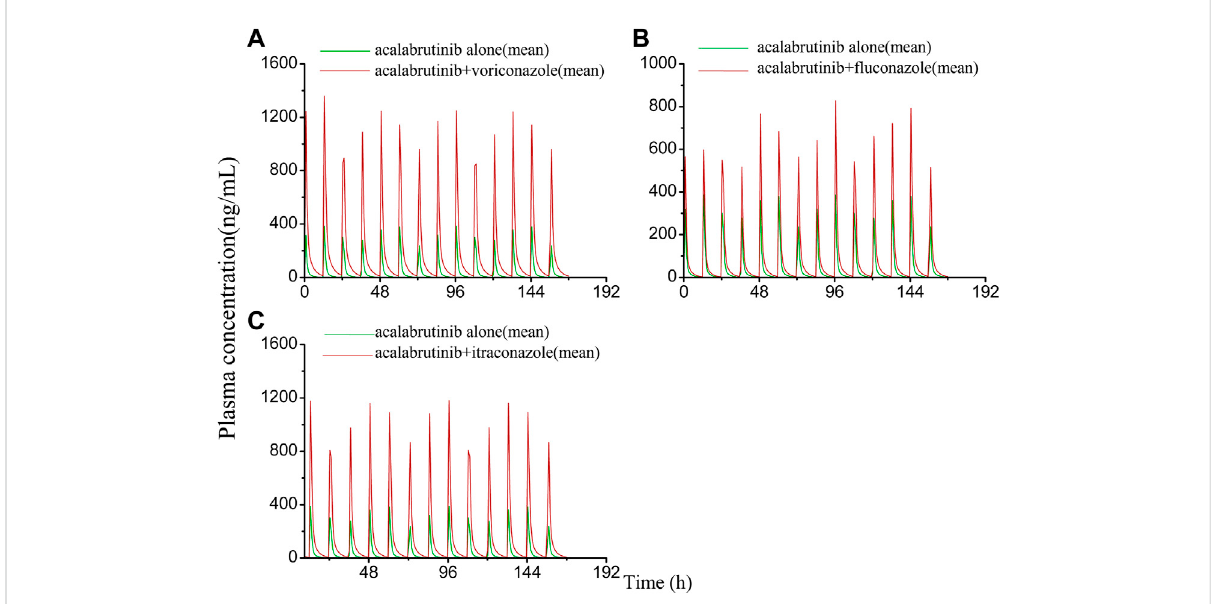
FIGURE 6 Simulated plasma concentrations of multiple doses (7 days doses) of acalabrutinib (100 mg twice daily) dosed alone or concomitant with (A) voriconazole (400 mg twice-daily (day 1) and a subsequent dose of 200 mg twice-daily); (B) fl uconazole (200 mg once daily); (C) itraconazole (200 mg once